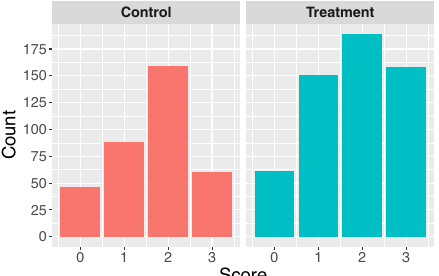
FIG. 3. Distribution of rubric scores for control and treatment